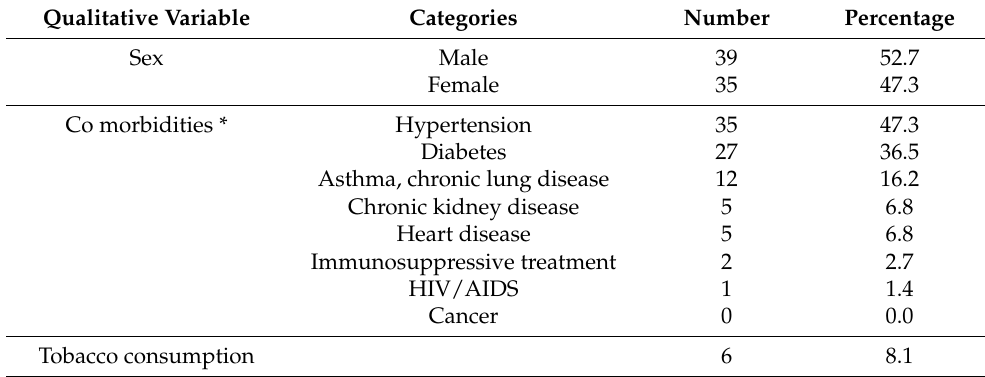
Table 1. Demographic and clinical characteristics of the patients with severe COVID-19 ( n =